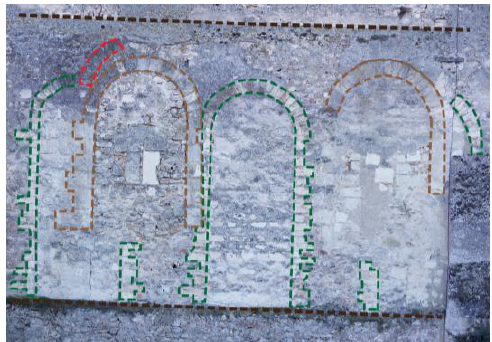
Figure 10 - Projections and plugged windows on the east face of St Paul